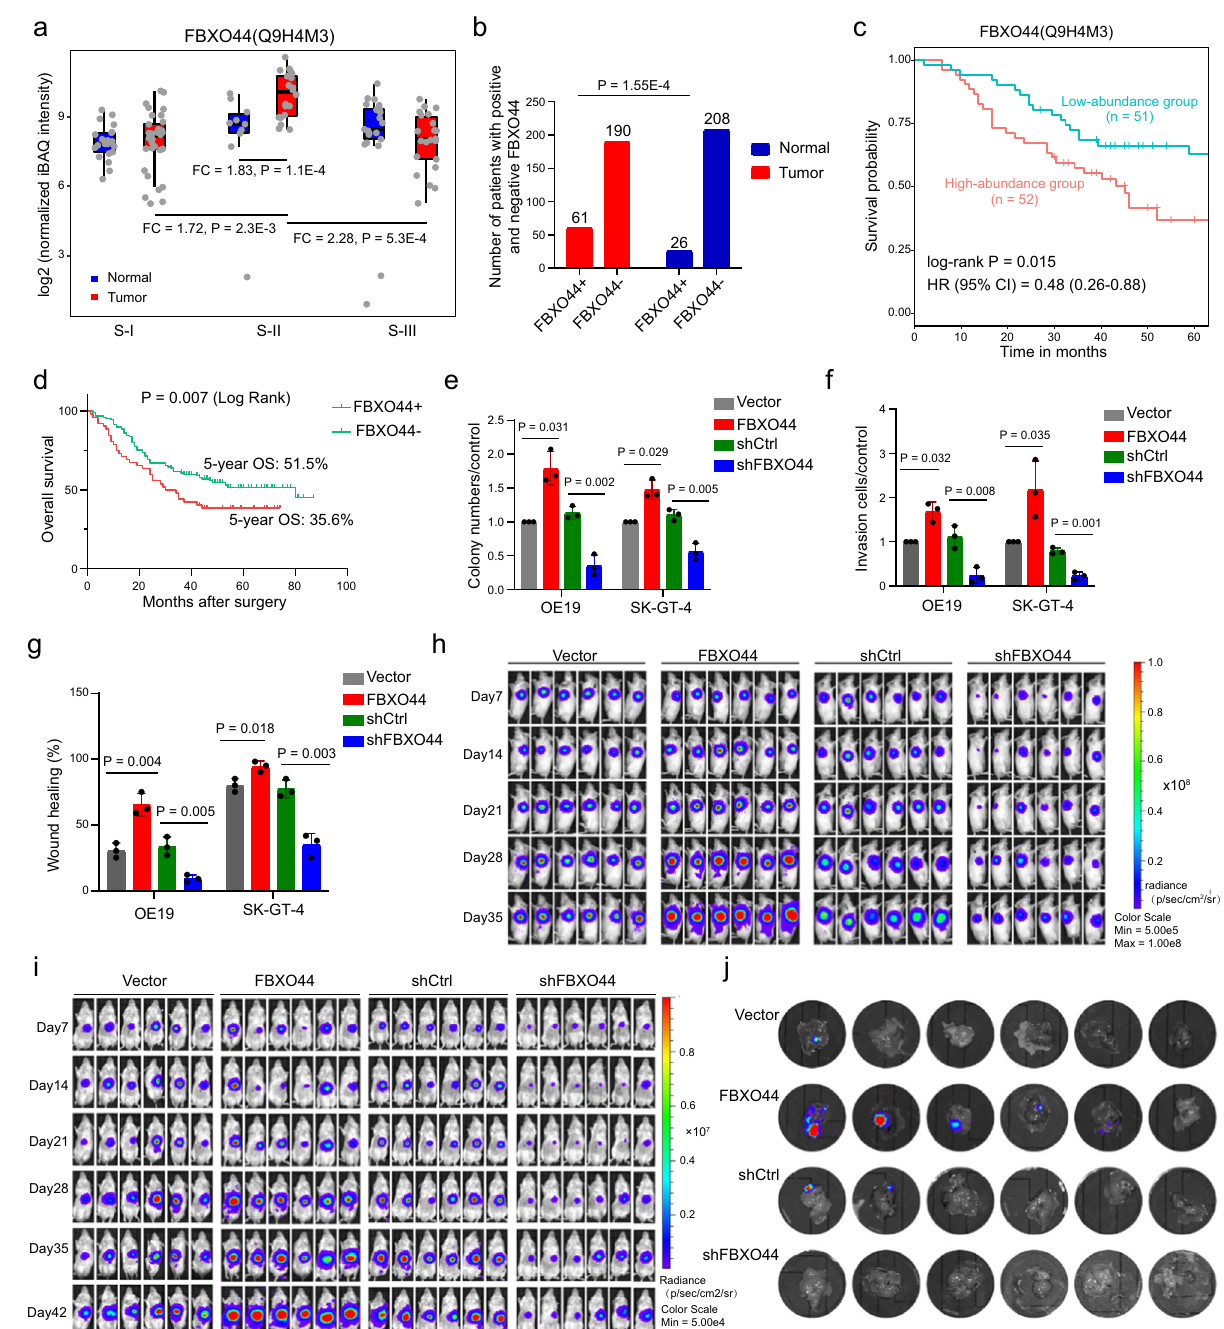
Fig. 4 | Clinical relevance and biological functions of FBXO44. a Comparison of FBXO44 protein abundance between tumor and NATsamples in each subtypeand tumors from different subtypes. FC indicates fold change ( n =40 for S-I, n =23 for S-II, n =40forS-III).EachboxrepresentstheIQRandmedianofnormalizedprotein abundanceinnormalortumorsamplesofeachsubtype,whiskersindicate1.5times IQR. P , two-sided Wilcoxon ’ s rank-sum test. b The distribution of FBXO44 in an independent cohort of tumor and NAT samples from 251 AEG patients. P , chi- squared test. c Kaplan – Meier survival curve comparing FBXO44-high ( n =52) and -low ( n =51) abundance patients. P , log-rank test. d Kaplan – Meier survival curve of FBXO44 in an independent clinical cohort ( n =61 for FBXO44+, n =190 for FBXO44 − ). P ,log-ranktest. e CellproliferationassaysofFBXO44OEorKDOE19and